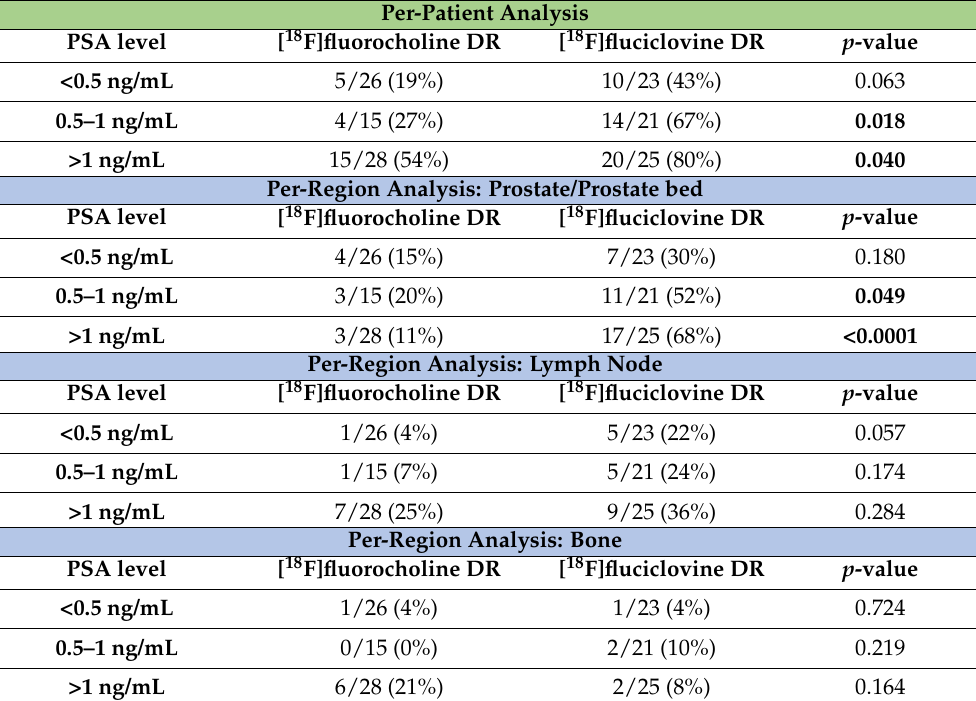
Figure 1. [ 18 F]fluorocholine and [ 18 F]fluciclovine PET/CT detection rate according to per-patient and per-region analysis. NS: non-significant p -value. Table 2. Per-patient and per-region detection rate (DR) analysis comparing the [ 18 F]fluorocholine and [ 18 F]fluciclovine groups stratified according to Prostate-Specific Antigen (PSA)